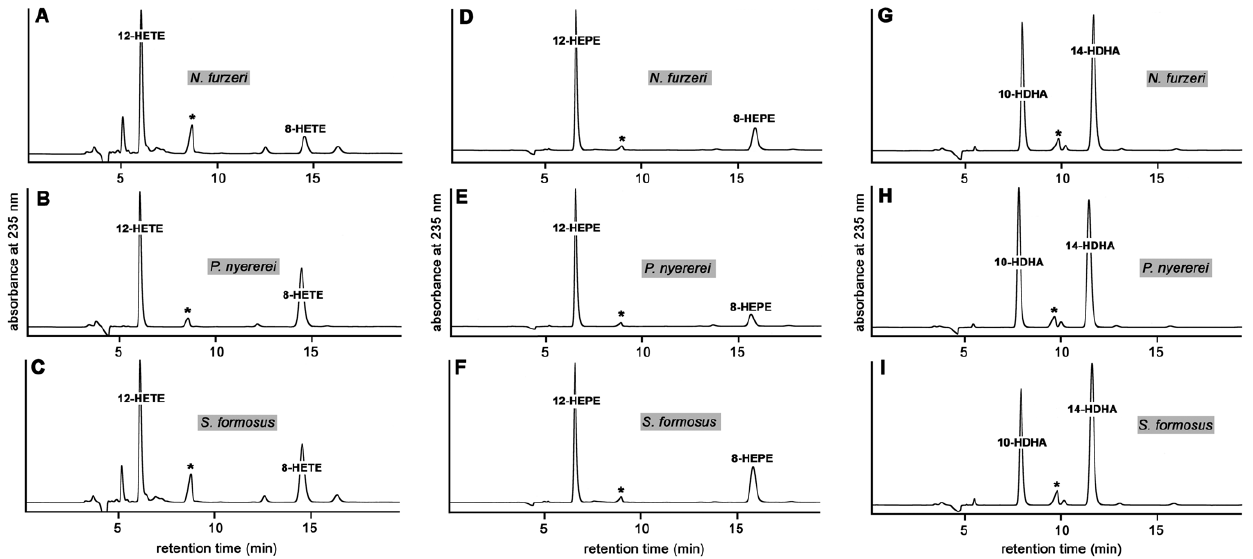
Figure 3. Identification of the major oxygenation products formed from arachidonic acid (AA), eicosapentaenoic acid (EPA) and docosahexaenoic acid (DHA). Activity assays were carried out with AA, EPA and DHA as ALOX substrate (100 µM). The major conjugated dienes formed during the incubation period were prepared by RP-HPLC and further analyzed by NP-HPLC. Product identity was concluded from co-chromatography with authentic standards in NP-HPLC. Two inde- pendent oxygenation assays were set up for each enzyme-substrate combination. Lipid extracts were pooled, conjugated dienes were prepared by RP-HPLC and further analyzed by NP-HPLC (see Section 4). (Panels A – C ) AA oxygenation products, (panels D – F ) EPA oxygenation products, (panels G – I ) DHA oxygenation products. * This peak does not show the classical uv-spectrum of a conjugated diene and thus may not be considered a fatty acid oxygenation product. For better com- parison of the product profiles each chromatogram was scaled to the highest conjugated diene peak and thus, direct comparison of the amounts of products formed by the different enzymes may not be possible.